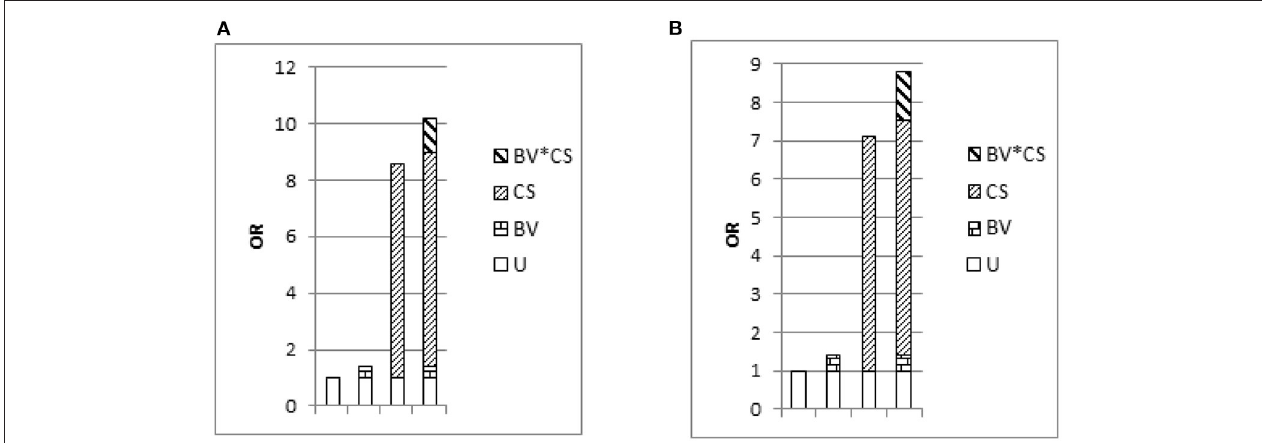
FIGURE 2 | Odds ratio with contributions from bullying victimization and current smoking marked. Notes: U is the common reference category (OR = 1); BV is bullying victimization; CS is current smoking; (A) outcome is none/frequent binge drinking, among drinkers, N = 15,109; (B) outcome is none/frequent binge drinking, among boy drinkers, N =